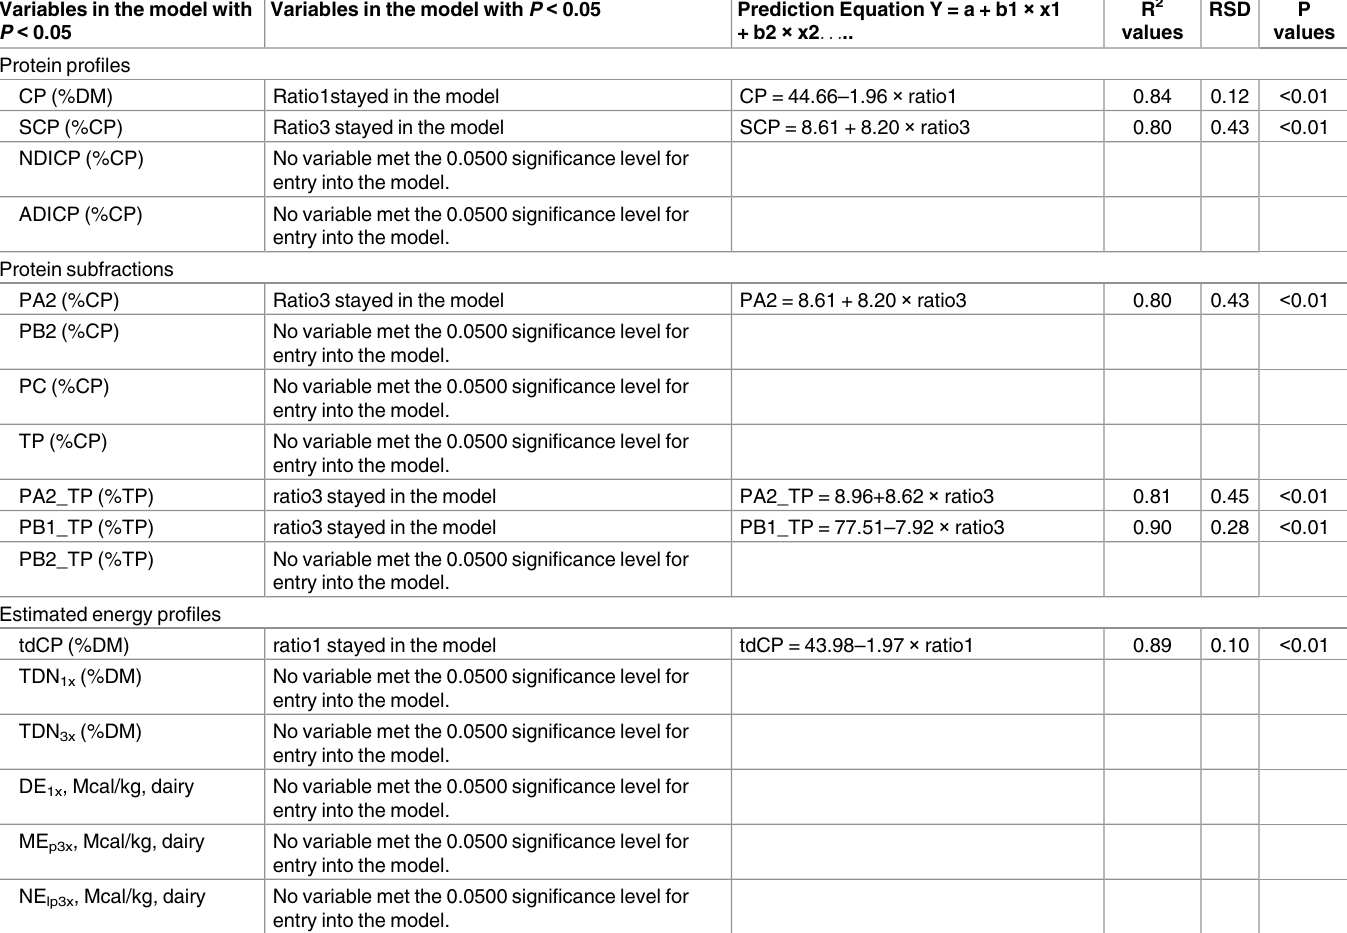
Table 2. Multi-regression analysis using ATR-FT/IR with tested regression model to detect the most important variables among protein spectral profiles in predicting nutrients profiles of canola meal. Variables in the model with P <